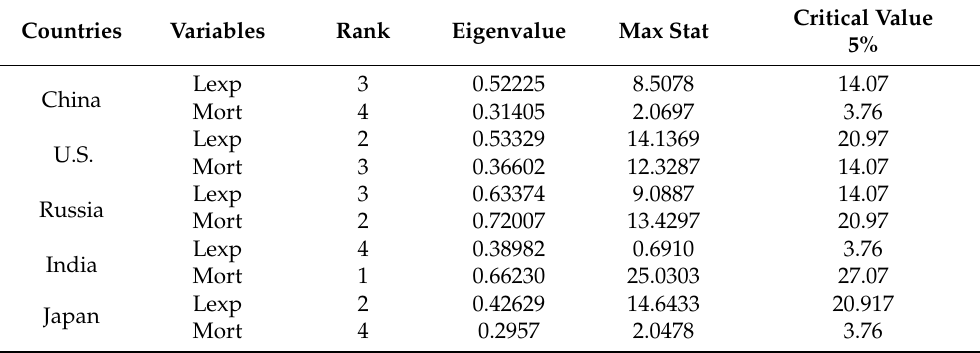
Table 9. Max statistic table for all five countries. Countries